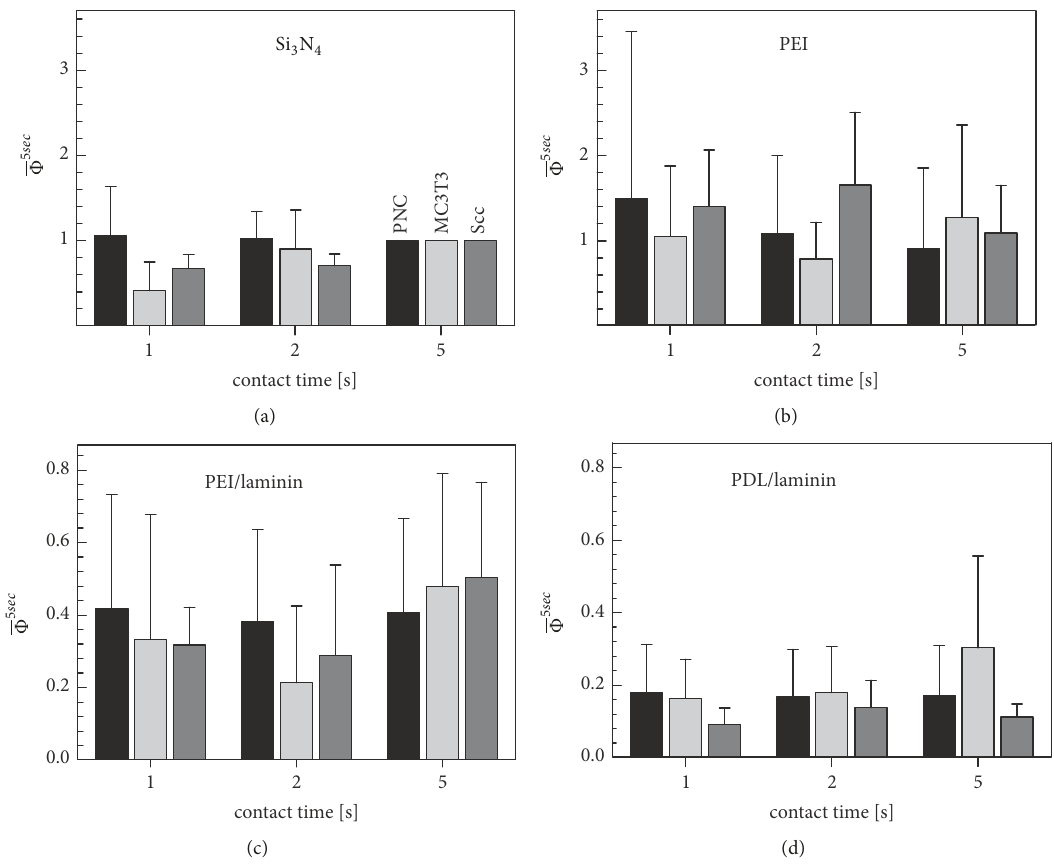
5𝑠𝑒𝑐 Figure 3: Mean relative MDFs ( Φ 𝑛,𝑠,𝑡 ) of PNCs (black), MC3T3 cells (light gray), and Scc cells (dark gray) on silicon nitride (a), PEI (b), PEI/laminin (c), and PDL/laminin (d) surfaces. Unit columns without scattering were obtained for the five-second MDFs on silicon nitride used as